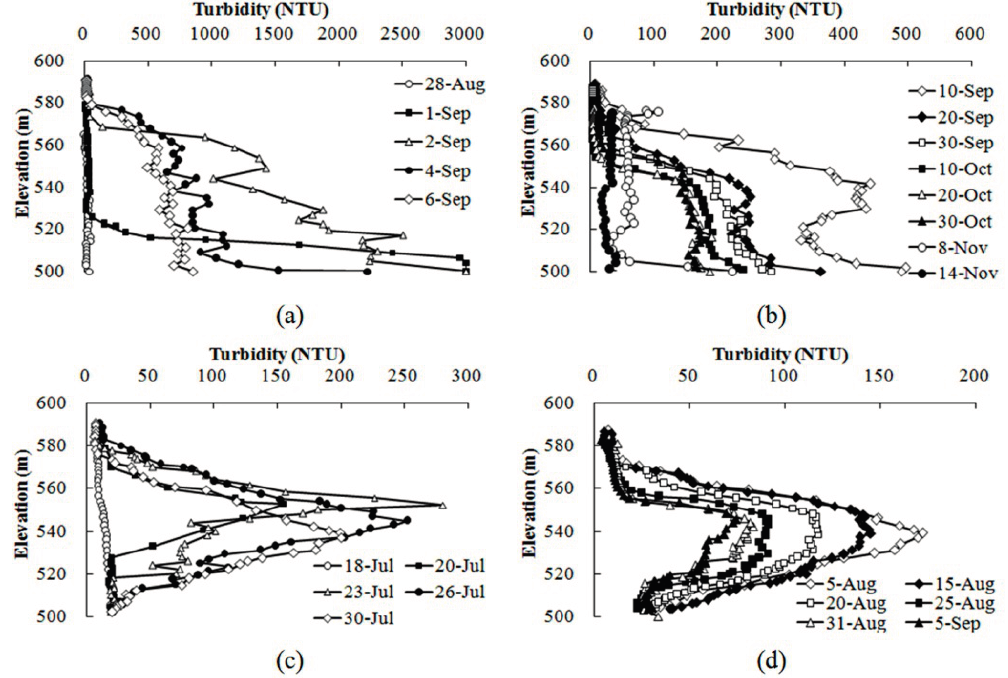
Figure 6. Vertical variation in turbidity during the flooding season in 2012 ( a , b ) and 2013 ( c , d ). The larger particles began to settle rapidly after the storm runoff, and water turbidity dropped from 3000 NTU to lower than 1000 NTU within a week (Figure 6a). The large amount of easily degraded organic matter transported into the reservoir by the storm runoff led to an increase in the oxygen consumption rate in the water, causing the water at the bottom of the reservoir to become anoxic again within 20 days of the storm runoff (Figure 5). Thereafter, the bottom water maintained its anaerobic state, until the reservoir mixed at the beginning of November due to the increased bottom water